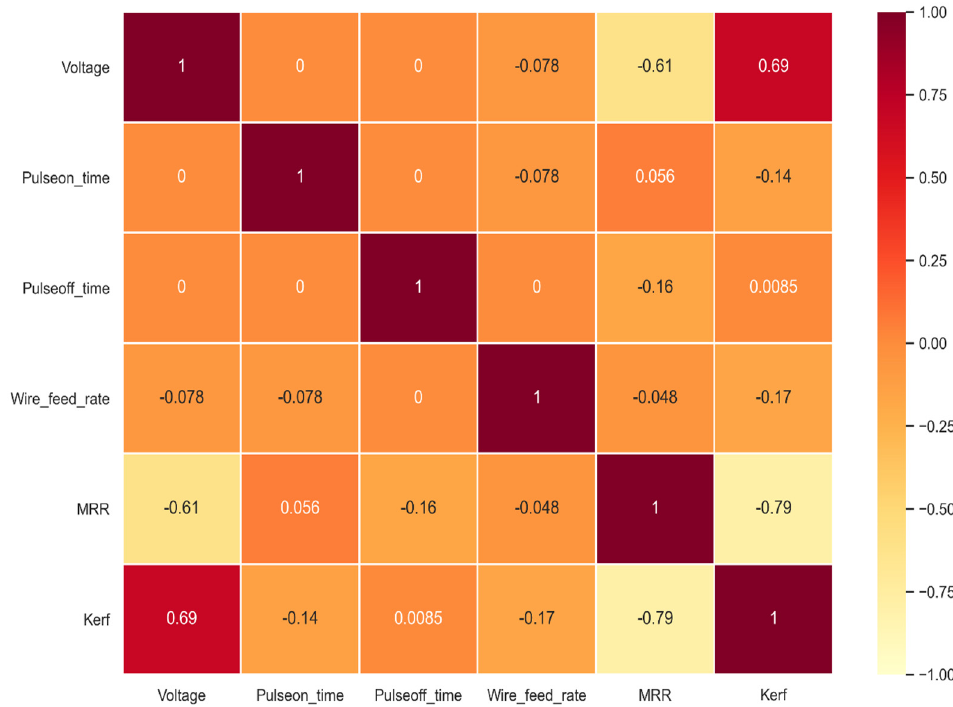
Figure 8. Correlation heatmap between the process parameters and the responses.